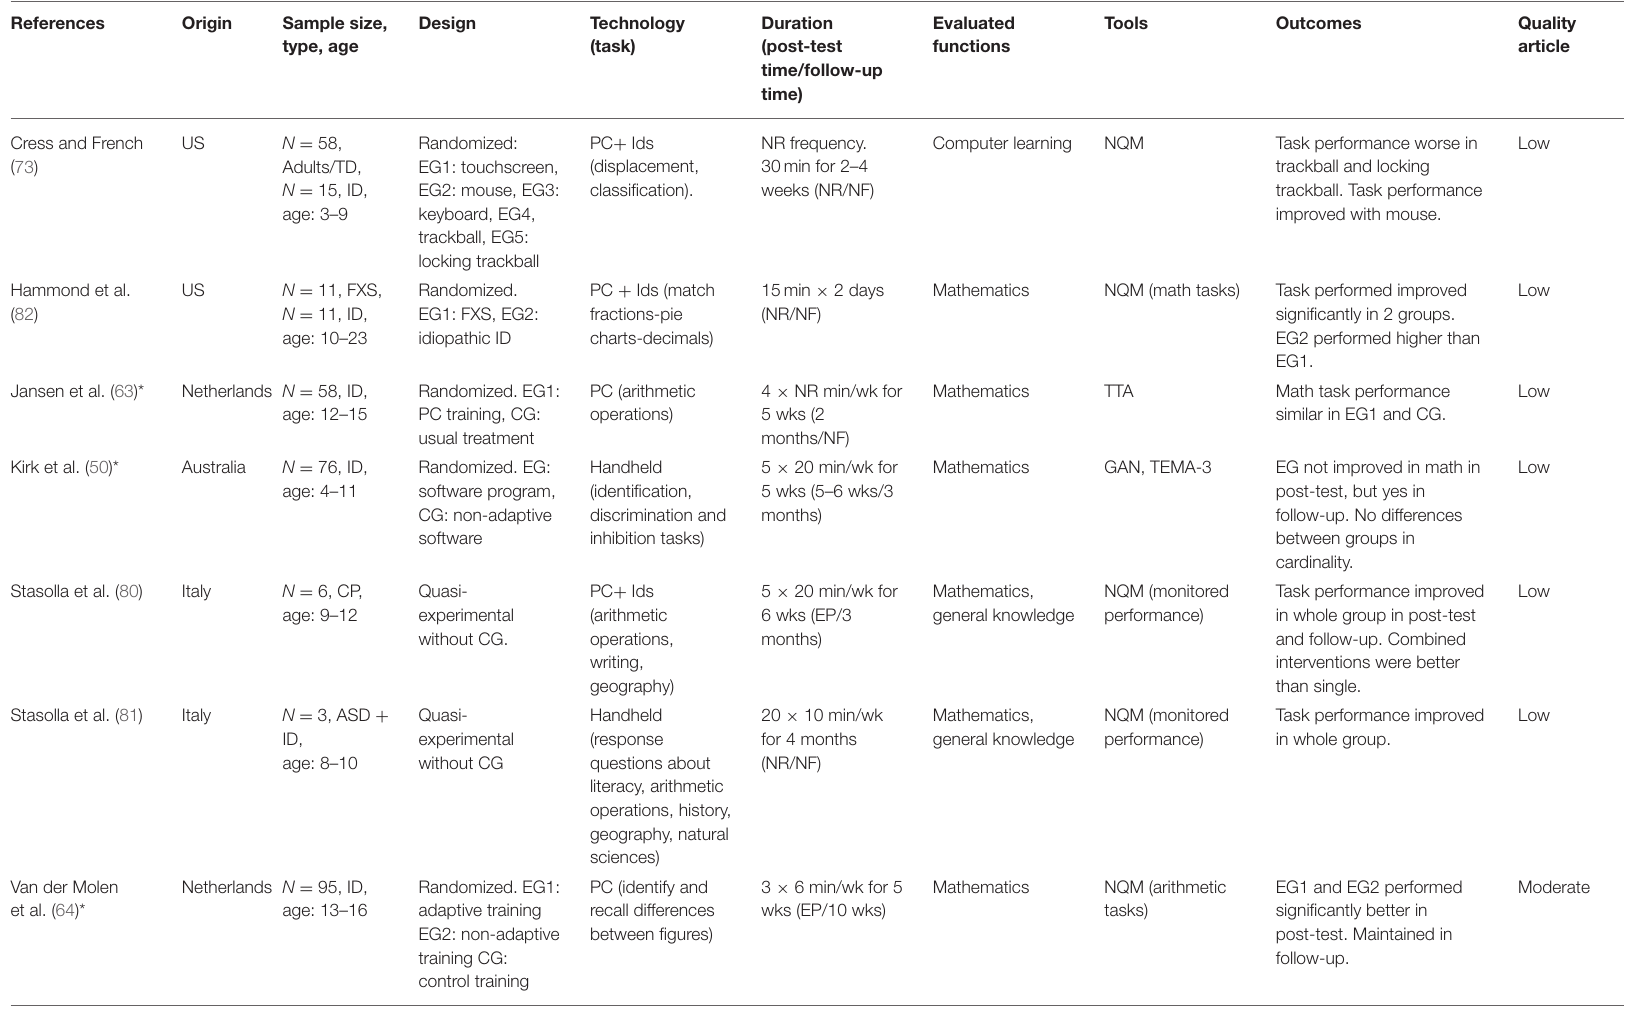
TABLE 4 | Reviewed studies focusing on academic